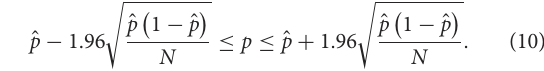
TABLE 2 Three constraints for calculating the expected width of 95% CI of λ L . Constraint Minimum Maximum sampling age sampling age Constraint 1 qL qL Constraint 2 0 rL Constraint 3 qL L